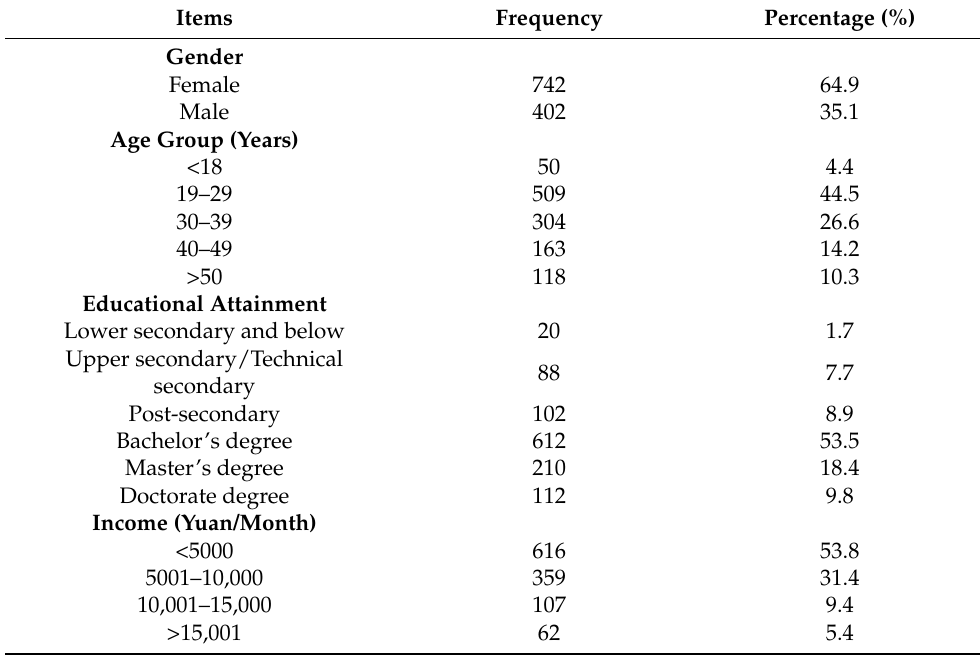
Table 1. Demographic